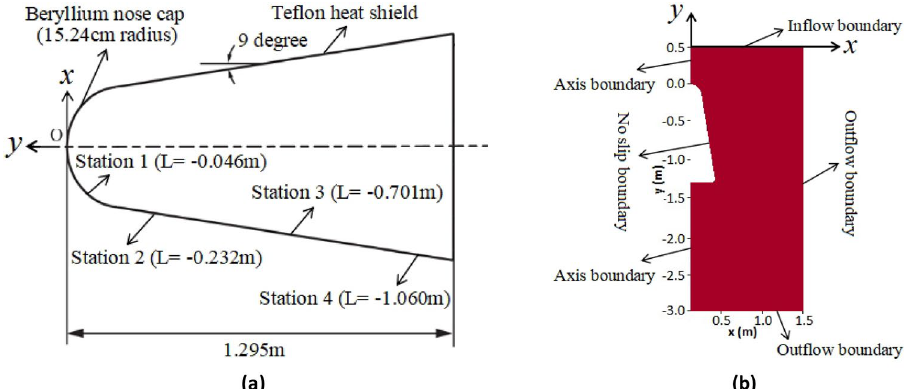
Figure 1. Shape configuration ( a ) and calculation oundary condition ( b ) of RAMC